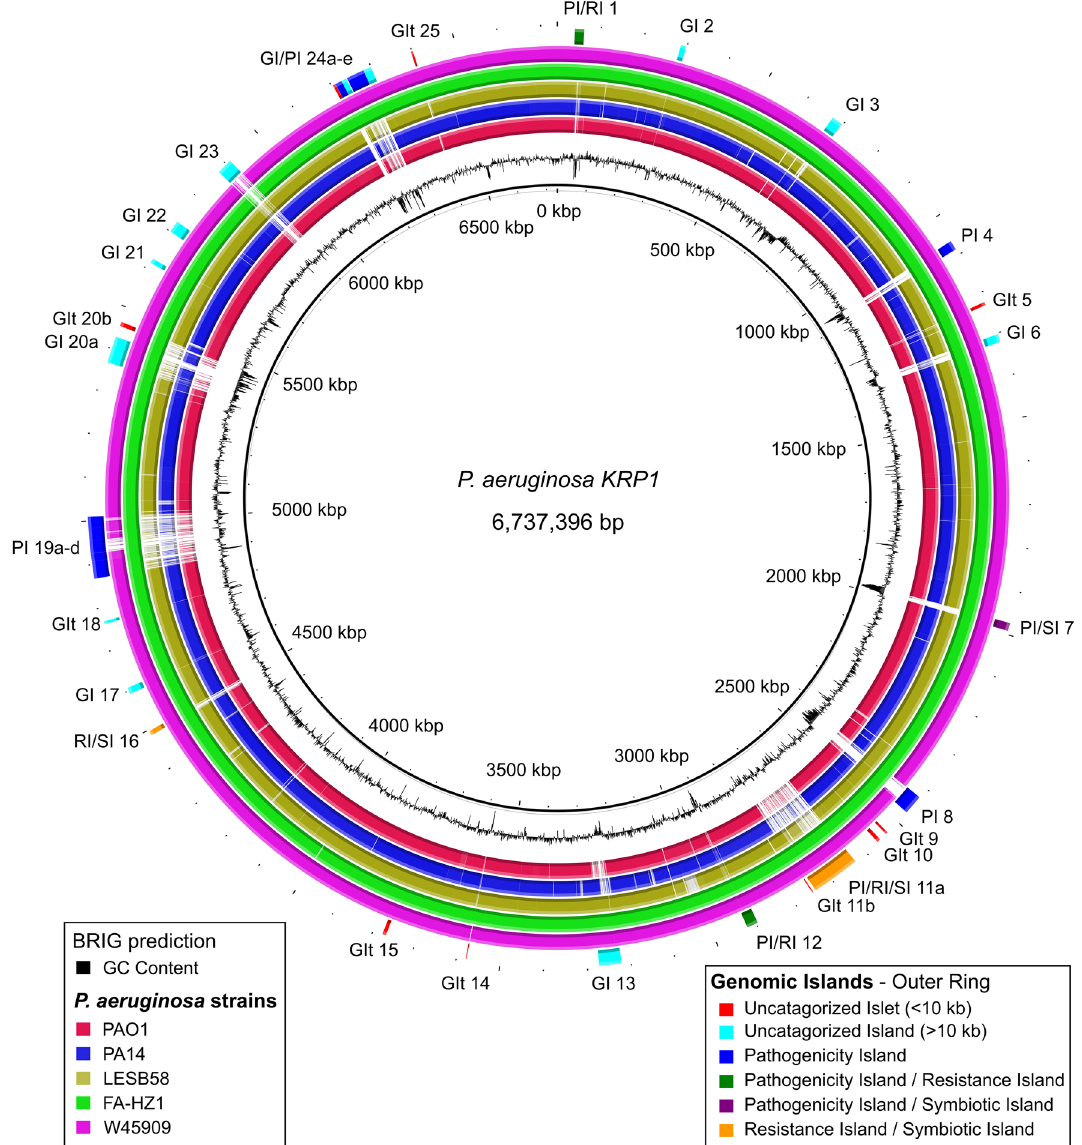
Figure 5. Visualization of genome plasticity in the P. aeruginosa KRP1 genome detected with different prediction programs. KRP1 main chromosome in comparison to selected P. aeruginosa genomes. Starting from the innermost circle going outwards: major- (500 kb) and minor tick (100 kb) measurements of the KRP1 genome; G + C content (black traces); BLAST comparisons of PAO1 genome against the KRP1 genome (red ring); BLAST comparisons of PA14 genome against the KRP1 genome (blue ring); BLAST comparisons of LESB58 genome against the KRP1 genome (ocher ring); BLAST comparisons of FA-HZ1 genome against the KRP1 genome (green ring); BLAST comparisons of W45909 genome against the KRP1 genome (magenta ring); combined genome plasticity prediction of SIGI-HMM 16 , IslandPath-DIMOB 17 , PHASTER 18 and GIPSy 19 , when comparing KRP1 to PA14 as a reference (red segments: uncategorized genomic islets [GIts]; aqua segments: uncategorized genomic islands [GIs]; blue segments: pathogenicity islands [PIs]; green segments: pathogenicity/ resistance islands [PI/RIs]; purple segments: pathogenicity/symbiotic islands [PI/SIs]; orange segments: resistance/symbiotic islands [RI/SIs]). Whole genome BLAST comparison and image generation was performed with BRIG 31